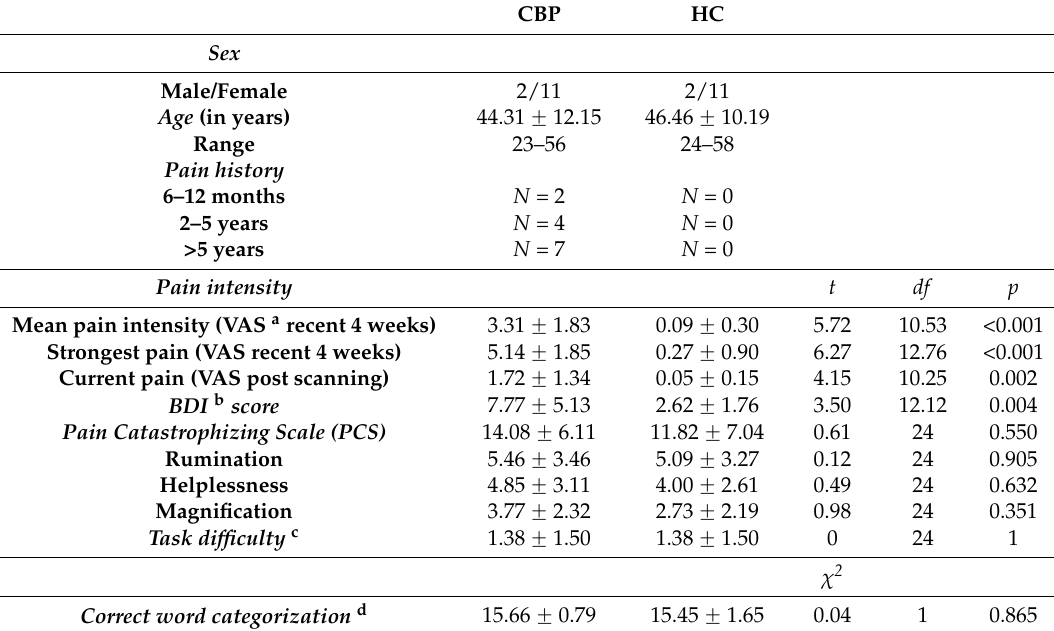
Table 1. Demographic and clinical characteristics as well as behavioral data of chronic back pain patients (CBP) and healthy controls